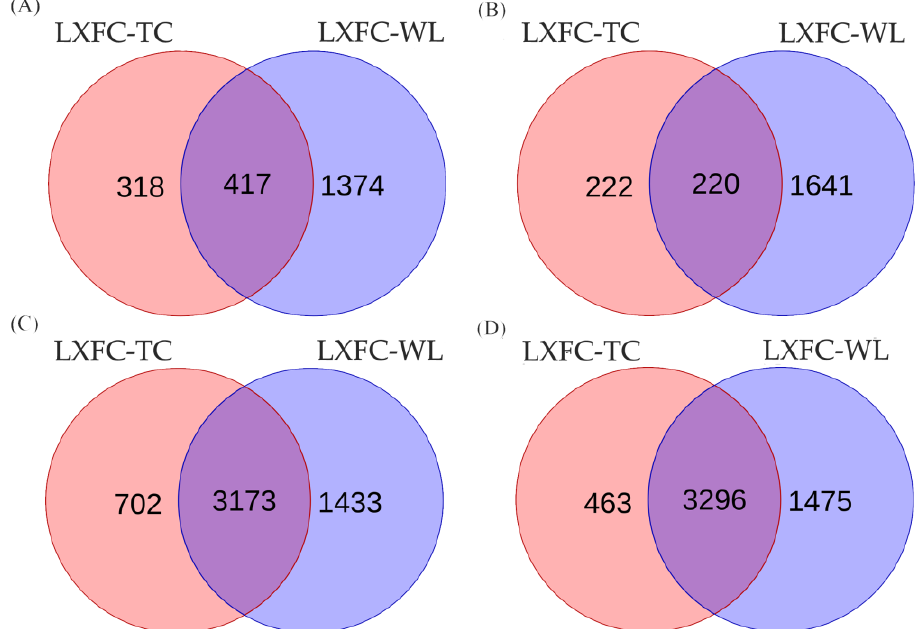
Figure 4. Venn diagrams of shared DEGs between the cerebral cortex and midbrain of LXFC-TC chickens and LXFC-WL chickens. ( A ) Shared down-regulated DEGs in the cerebral cortex between LXFC-TC and LXFC-WL chickens. ( B ) Shared up-regulated DEGs in the cerebral cortex between LXFC-TC and LXFC-WL chickens. ( C ) Shared down-regulated DEGs in the midbrain between LXFC-TC and LXFC-WL chickens. ( D ) Shared up-regulated DEGs in the midbrain between LXFC-TC and LXFC-WL chickens.